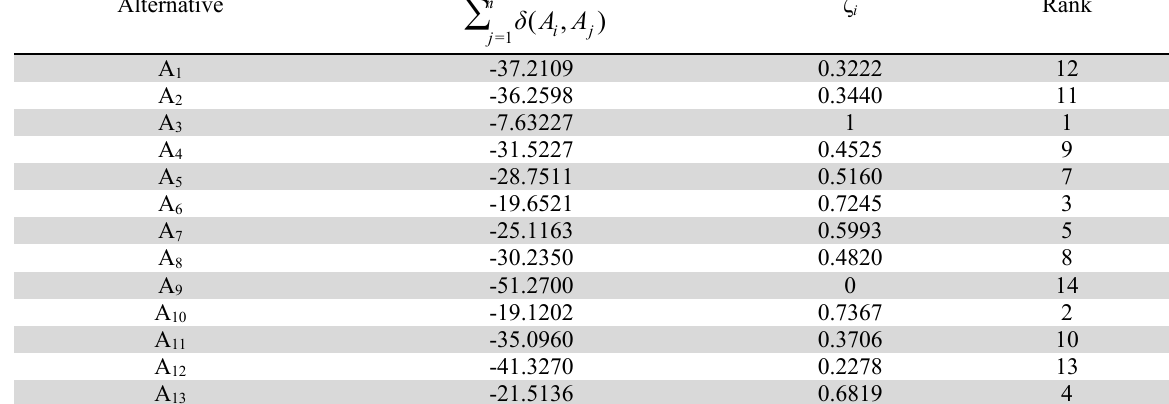
Overall dominance degrees of the housing projects